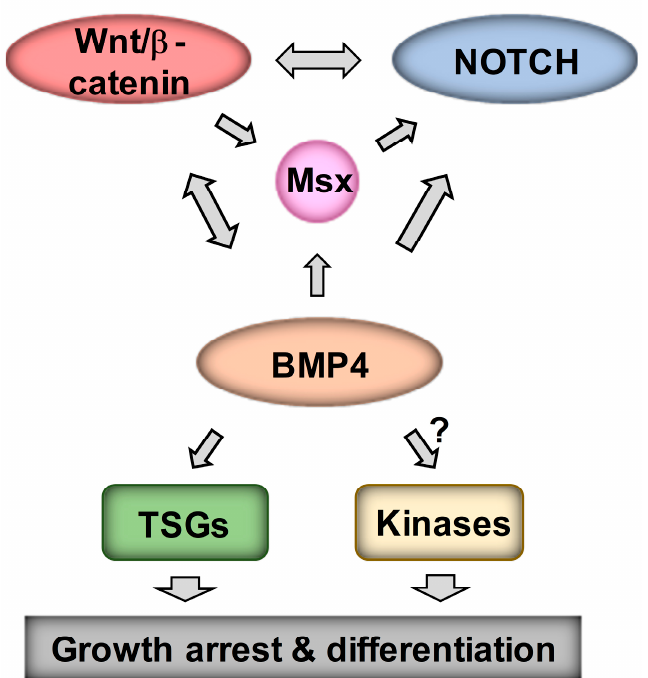
Figure 8. Model for Wnt, BMP, MSX and Notch crosstalk. Regulatory interactions promoting growth arrest and differentiation in neuroblastoma are outlined.